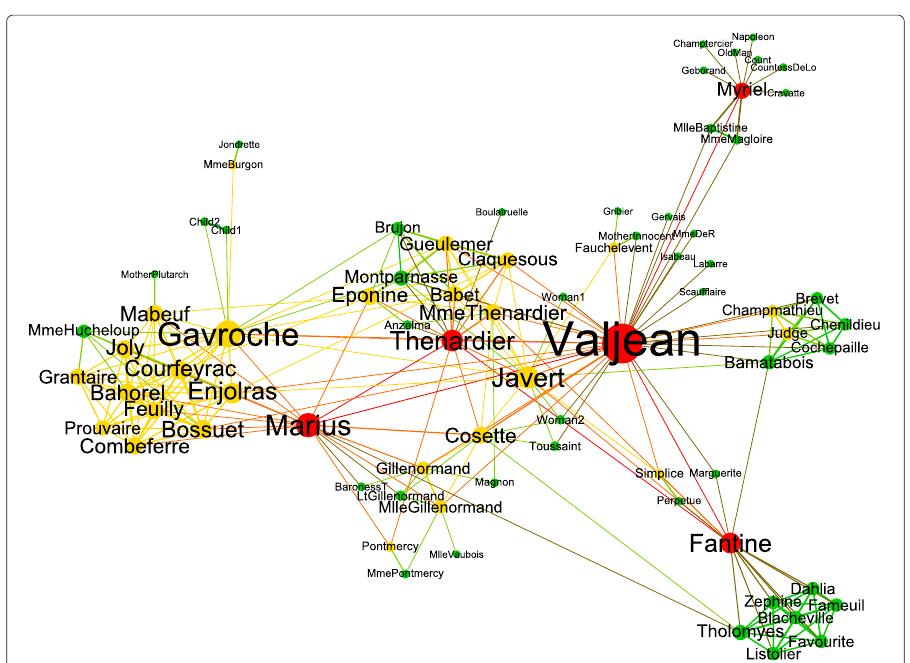
Fig. 18 Les Misérables network. Strongly-prominent nodes (red) link densely connected groups in the network. Weakly-prominent nodes (yellow) occur in different situations where they can be mutually dependent or dependent on some strongly-prominent nodes. However, at least one other node must be one-way dependent on each of them. On the left, there is a structure composed of predominantly weakly-prominent nodes; the zone network in Fig. 7b shows that in such a structure, there are several multi-ego and alternative